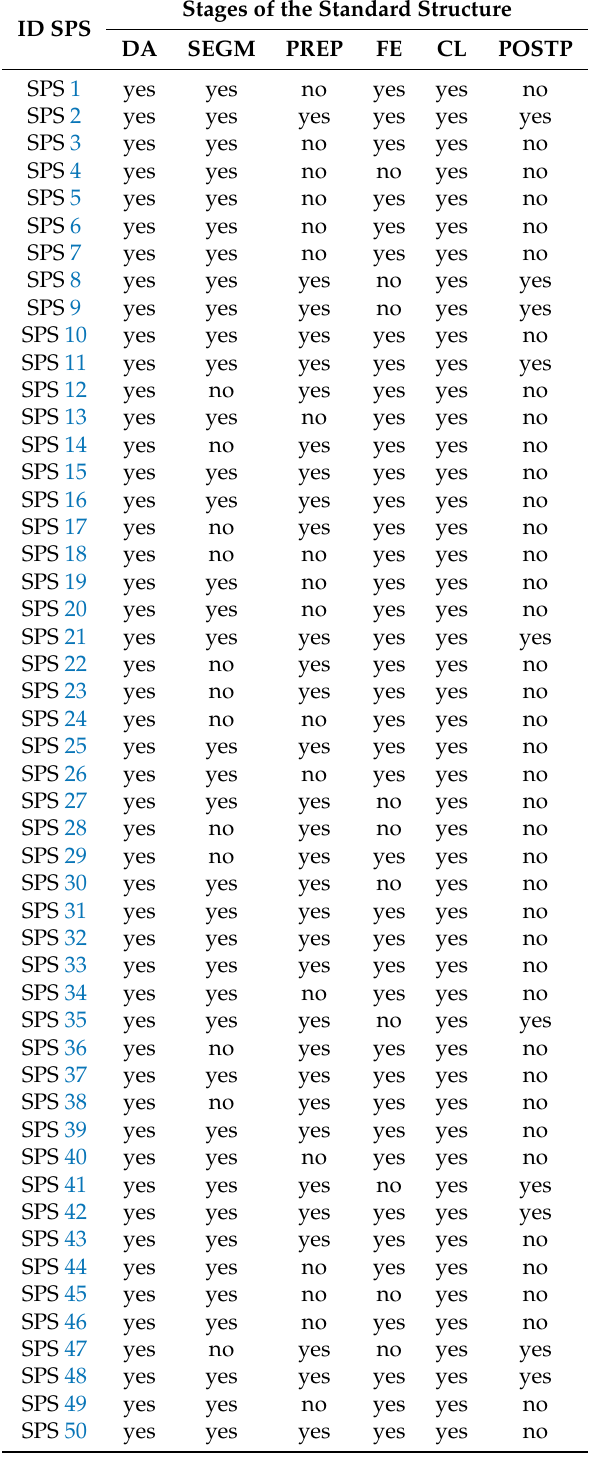
Table 6. Standard structure used by the 65 HGR